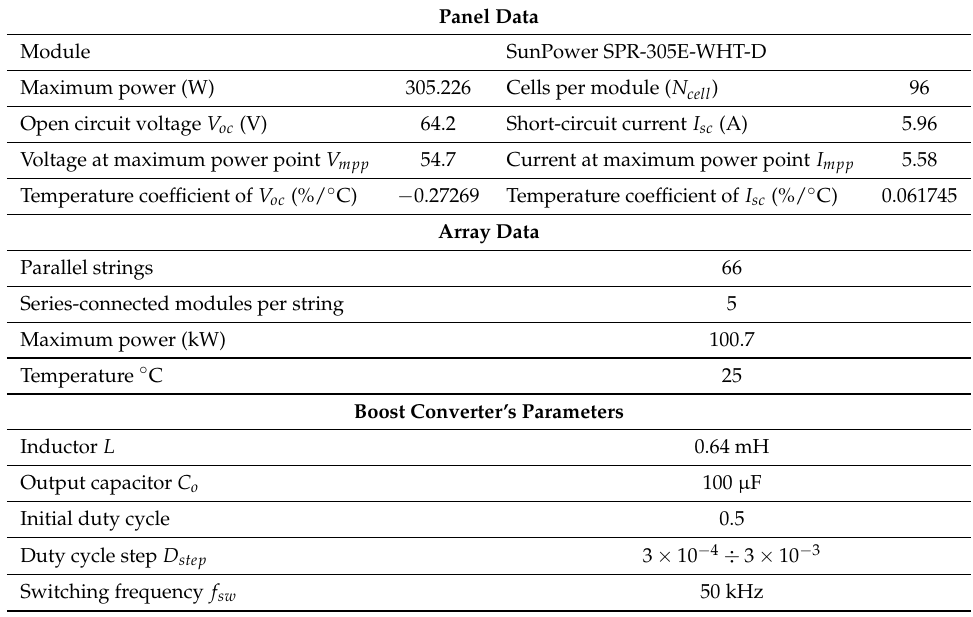
Table 2. Characteristics of the PV panel, PV array structure, and DC/DC boost converter parameters.